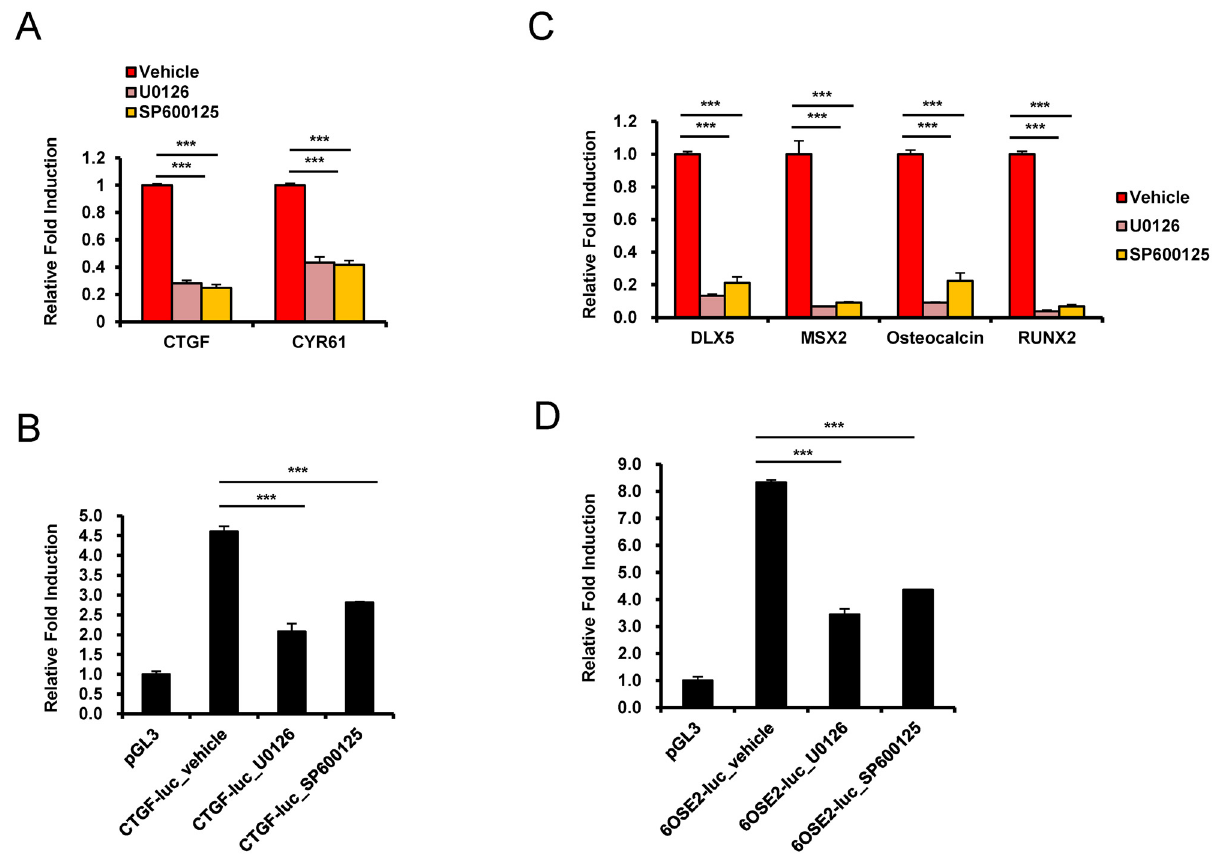
Fig 4. Stiffness-regulated ERK/JNK activity is crucial for TAZ target gene expression and osteogenesis at the transcriptional level. (A) hMSCs cultured on the 4.47 kPa hydrogel were treated with a MEK inhibitor (U0126, 10 μ M) or a JNK inhibitor (SP600125, 10 μ M). After 12 h, total RNA was prepared, and CTGF and CYR61 expression was assessed by qRT-PCR. The results showed that CTGF and CYR61 were downregulated following inhibition of ERK or JNK in cells on the stiff hydrogel. (B) The CTGF-luc reporter gene construct or the control pGL3-basic vector was transfected into hMSCs, and after 16 h, the transfected cells were plated on 4.47 kPa hydrogels. After 24 h, luciferase reporter gene activity was analyzed. To inhibit ERK or JNK, cell were pretreated with 10 μ M U0126 or 10 μ M SP600125, respectively, 12 h before reporter gene analysis. A Renilla luciferase-expressing vector was used as a transfection control. Luciferase activity was normalized to Renilla luciferase activity. (C) hMSCs were differentiated into osteoblasts for 6 days in the presence of 10 μ M U0126 or 10 μ M SP600125. DMSO was used as the vehicle control. The expression of osteoblastic marker genes, including DLX5 , MSX2 , osteocalcin, and RUNX2 , were analyzed by qRT-PCR. Gene expression was normalized to GAPDH . The results show that the expression of the osteogenic marker genes in cells on a 4.47 kPa hydrogel was significantly suppressed by ERK or JNK inhibition. (D) hMSCs were transfected